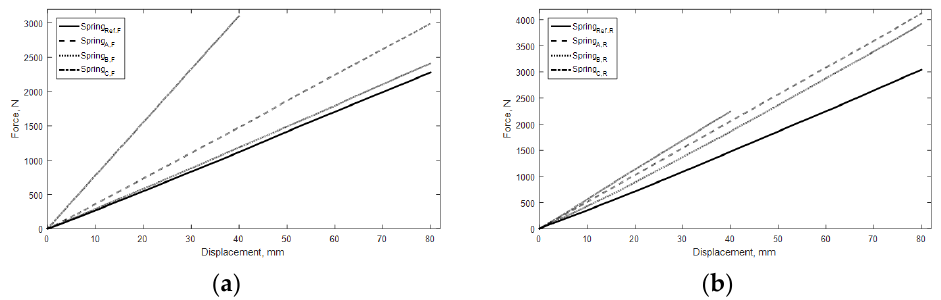
Figure 6. Spring characteristics test results: ( a ) Front spring characteristics; ( b ) Rear spring characteristics.